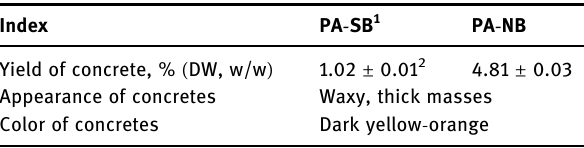
Table 4: Principle indices of the obtained concretes from P. alke